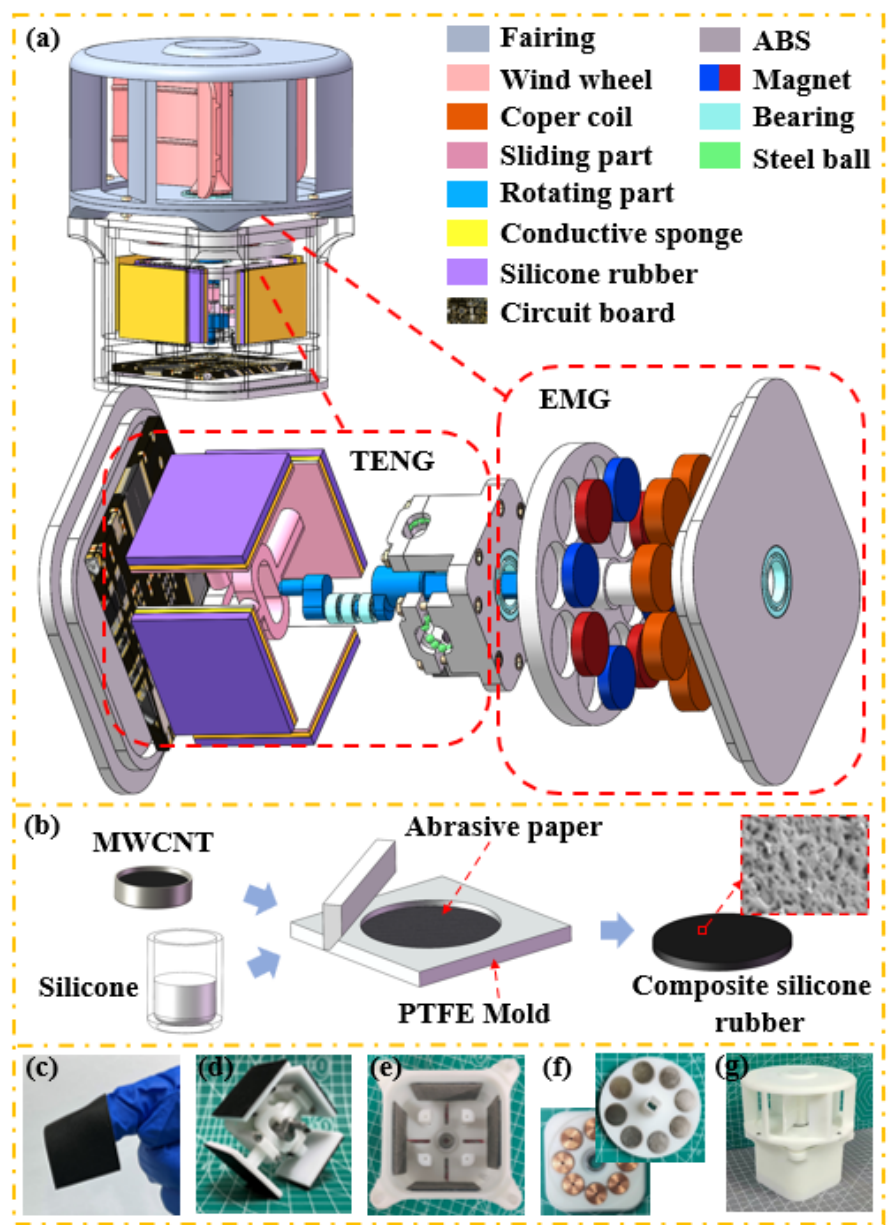
Figure 1. Structure of the ECD: ( a ) schematic of the ECD; ( b ) preparation process of modified silicone rubber; ( c ) photo of modified silicone rubber; ( d ) photo of the optimized Scotch yoke structure; ( e ) photo of the all ‐ directional conductive foam electrode; ( f ) photo of the electromagnetic layout; ( g ) photo of the ECD.